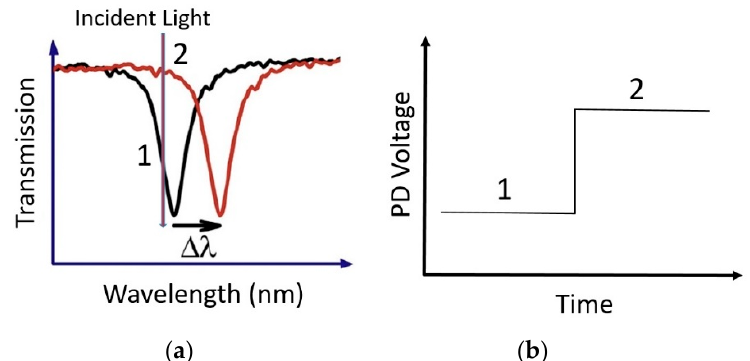
Figure 4. ( a ) Resonance wavelength shift due to change in the refractive index. Keeping the incident wavelength fixed (red vertical arrow), the intensity of light impinging on the PD changes from level 1 to level 2 resulting in the increase in the PD output voltage/current from level 1 to 2 as shown in ( b ).